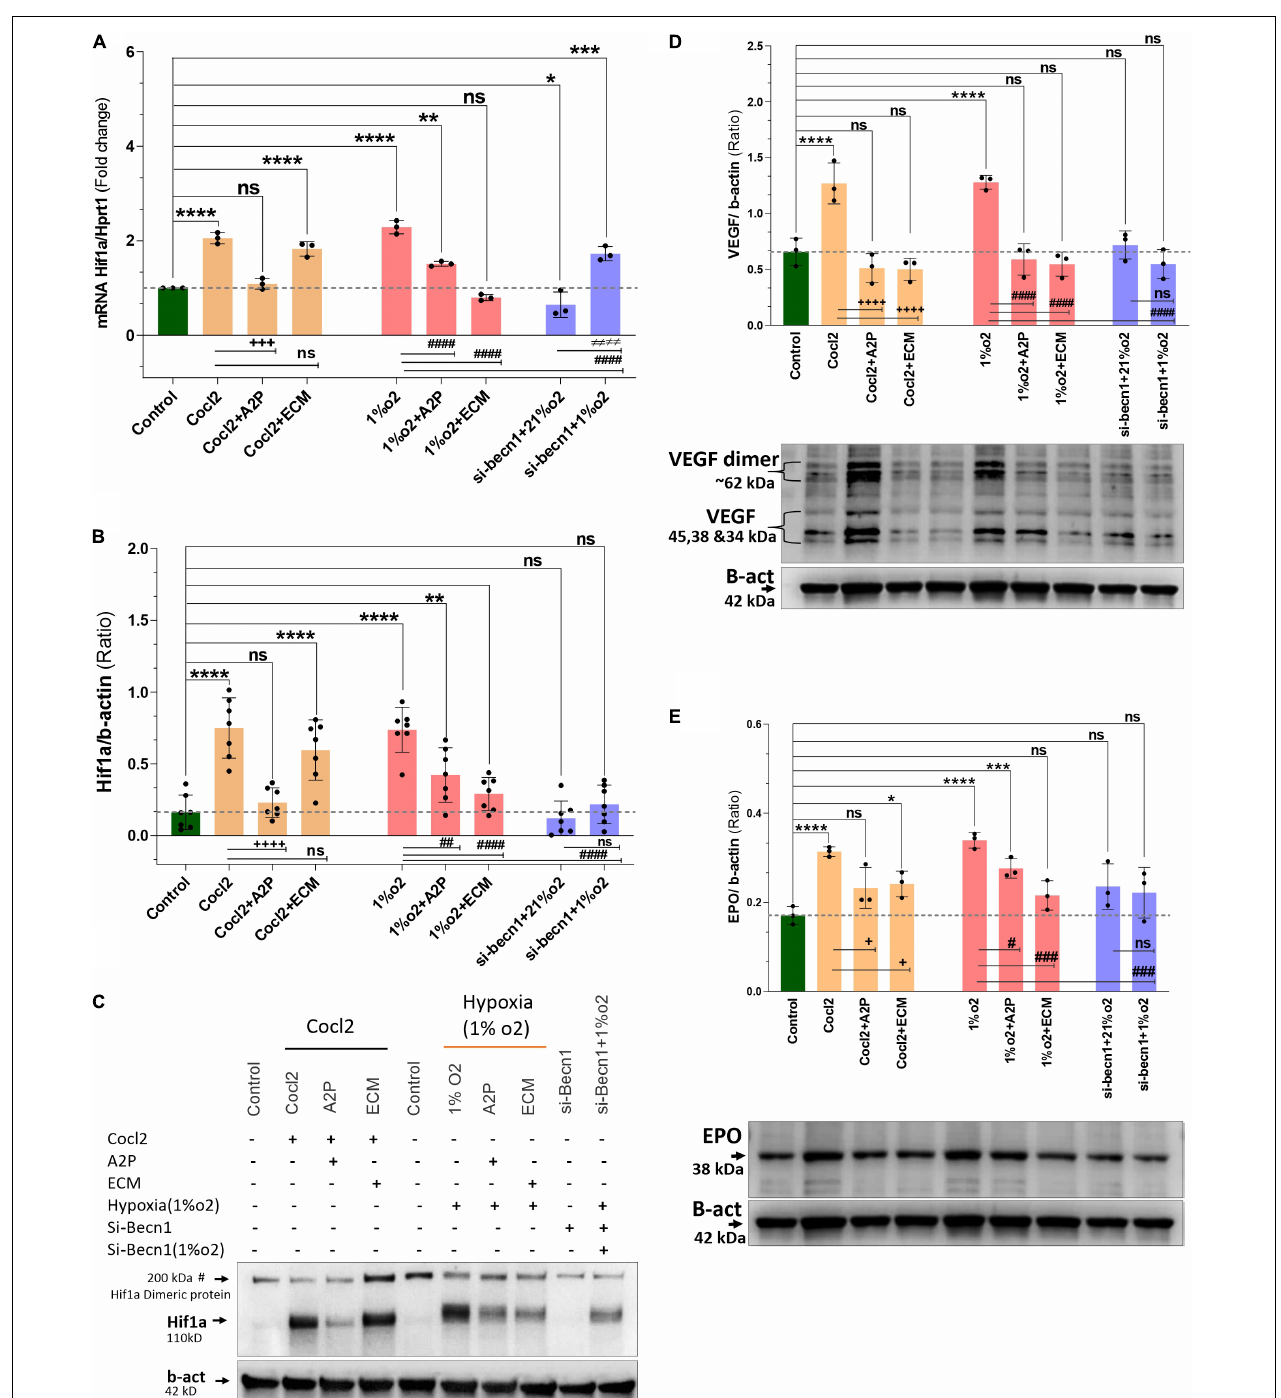
FIGURE 7 | Hypoxia and Cocl2 exposure increase the H9c2 cells HIF1 α and downstream targets VEGF and EPO expression levels. (A) Hif1 α mRNA levels (B) Hif1 α Protein expression levels (C) representative western blots showing Hif1 α protein levels. (D) VEGF protein expression levels and representative western blots. (E) EPO protein expression levels and representative western blots. Compared to control cells, Hif1 α mRNA increased in cells exposed to Cocl2 (**** p < 0.0001), Cocl2 + ECM (**** p < 0.0001), Hypoxia (1%O2) ** p < 0.0001, and Hypoxia (1%O2) + A2P, ** p < 0.001. Beclin-1 inhibition reduced the Hif1 α mRNA levels in normoxia (21%O2) *p < 0.027 and increased in hypoxia (1%O2) exposed cells, **** p < 0.0001. In addition, compared to Cocl2 exposed cells, CoCl 2 + A2P ( +++ p < 0.0004), compared to Hypoxia (1%O2) cells, 1%O2 + A2P ( #### p < 0.0001), 1%O2 + ECM ( #### p < 0.0001), and beclin-1 inhibition cells grown under Hypoxia ( #### p < 0.0001) expressed significantly decreased the Hif1 α mRNA levels. As expected, Hif1 α protein expression levels was increased in Cocl2 (**** p < 0.0001), and in Hypoxia (**** p = 0.0001) cells. Compared to controls, Cocl2 + ECM cells showed increased Hif1 α protein expression